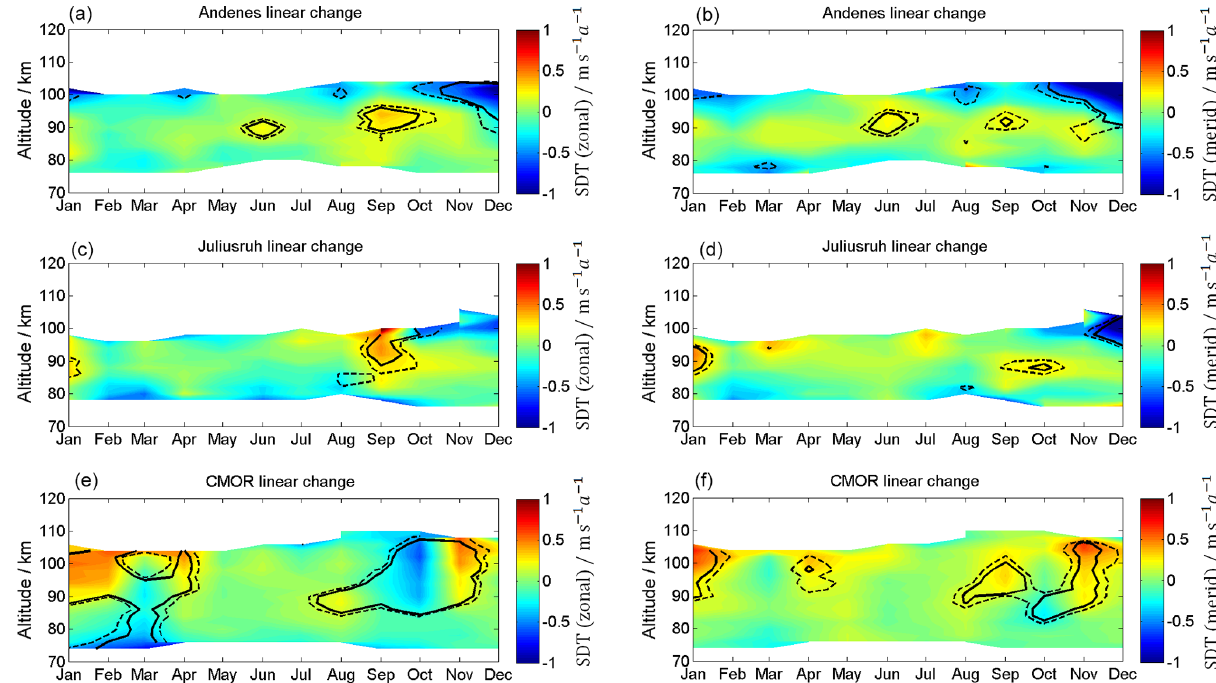
Figure 14. Same as Fig. 10 but for the semidiurnal tidal